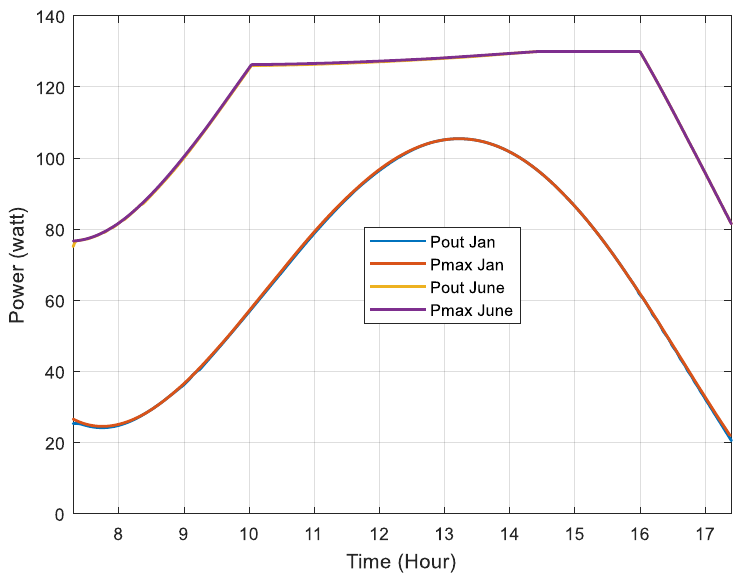
Energies 2019 , 12 , x FOR PEER REVIEW 15 of 18 Figure 16. Voltage, current, dP/dV, and D for a combination of step and ramp values of irradiance at 25 ℃. The real irradiance and temperature values in Figure 1 were used to test the controller’s